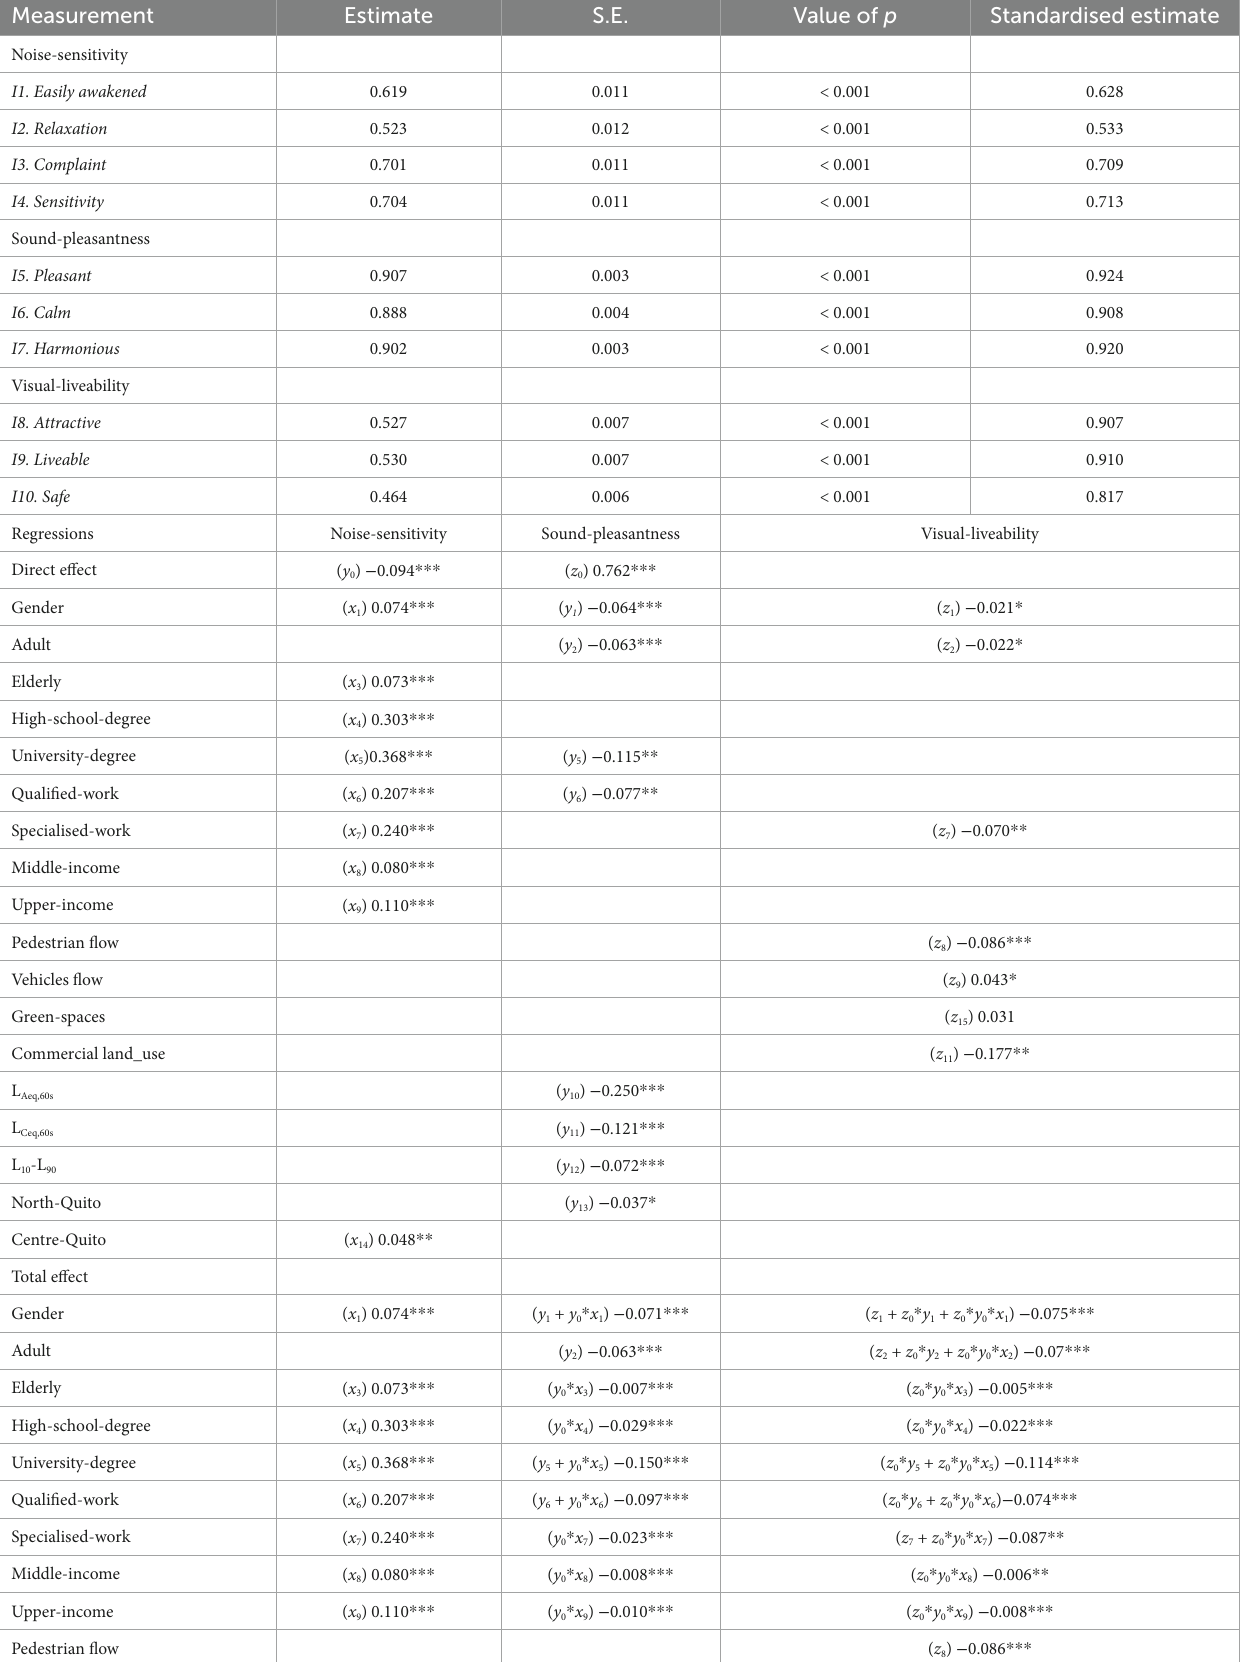
TABLE 8 Full structural equation model, measurement, and regressions. Measurement Estimate S.E. Value of p Standardised